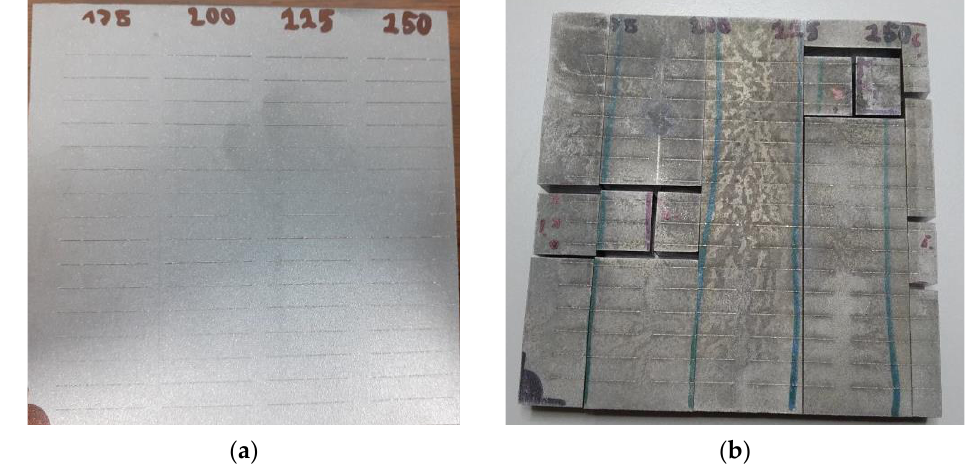
Figure 3. ( a ) Building platform with printed single tracks; ( b ) Platform cutting system with single